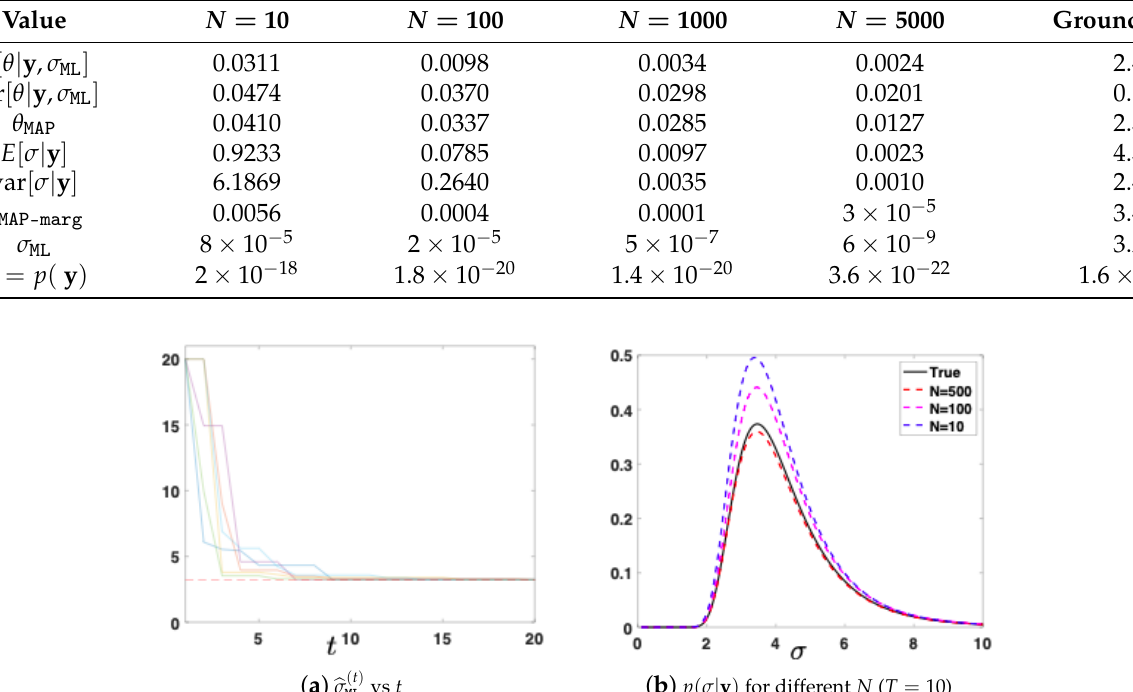
Figure 3a. The approximation of the marginal posterior p ( σ | y ) , denoted (cid:98) p ( σ | y ) , is obtained as in Equation (27) in one specific run, with different N ∈ { 10, 100, 500 } and T = 10. The approximations of the joint posterior p ( θ , σ | y ) and the marginal posterior p ( θ | y ) , obtained by resampling the particles according to the normalized weights in Equations (31) and (24), details, see in [14] and Chapter 24 in [15]. Table 2. Mean Square Error (MSE) of ATAIS (averaged over 500 runs), in the estimation of the evidence, different moments and modes as function of N and T = 10.